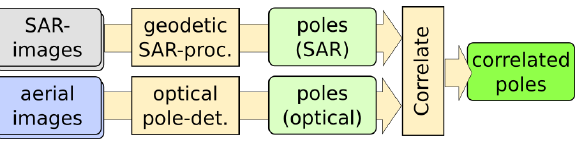
Figure 4. Overview of method